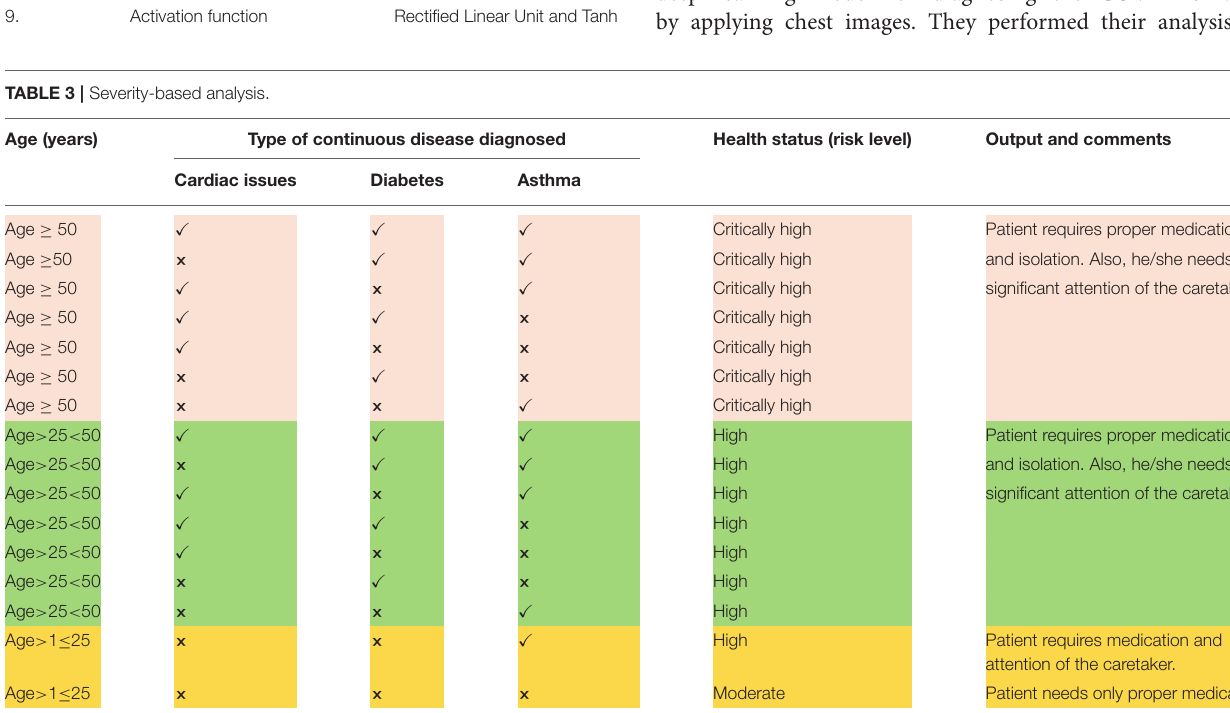
Colors are used to differentiate in-between different age